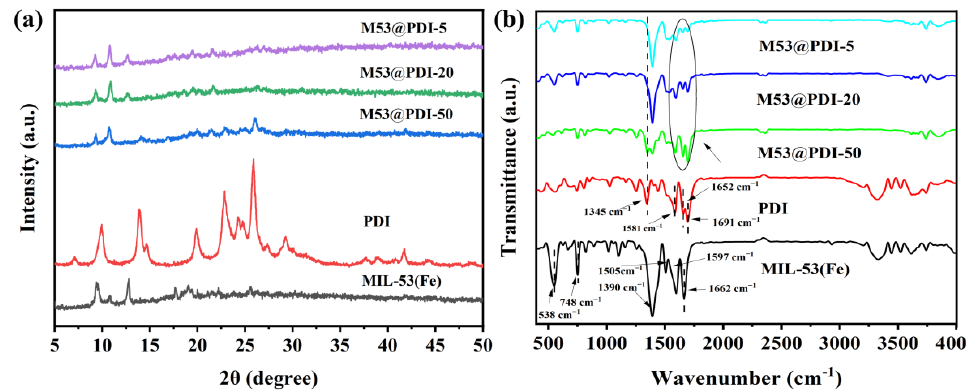
Figure 1. XRD patterns ( a ) and FT-IR spectra ( b ) of PDI, MIL-53(Fe) and MIL-53(Fe)@PDI hetero- junctions.